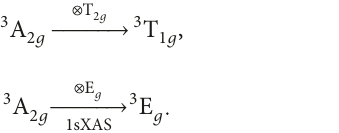
Figure 18: 1s XAS projections of the calculated 1s2p RIXS map for Ni 2+ (3d 8 ) showing only one peak as the T The red lines indicate the energy levels of the intermediate